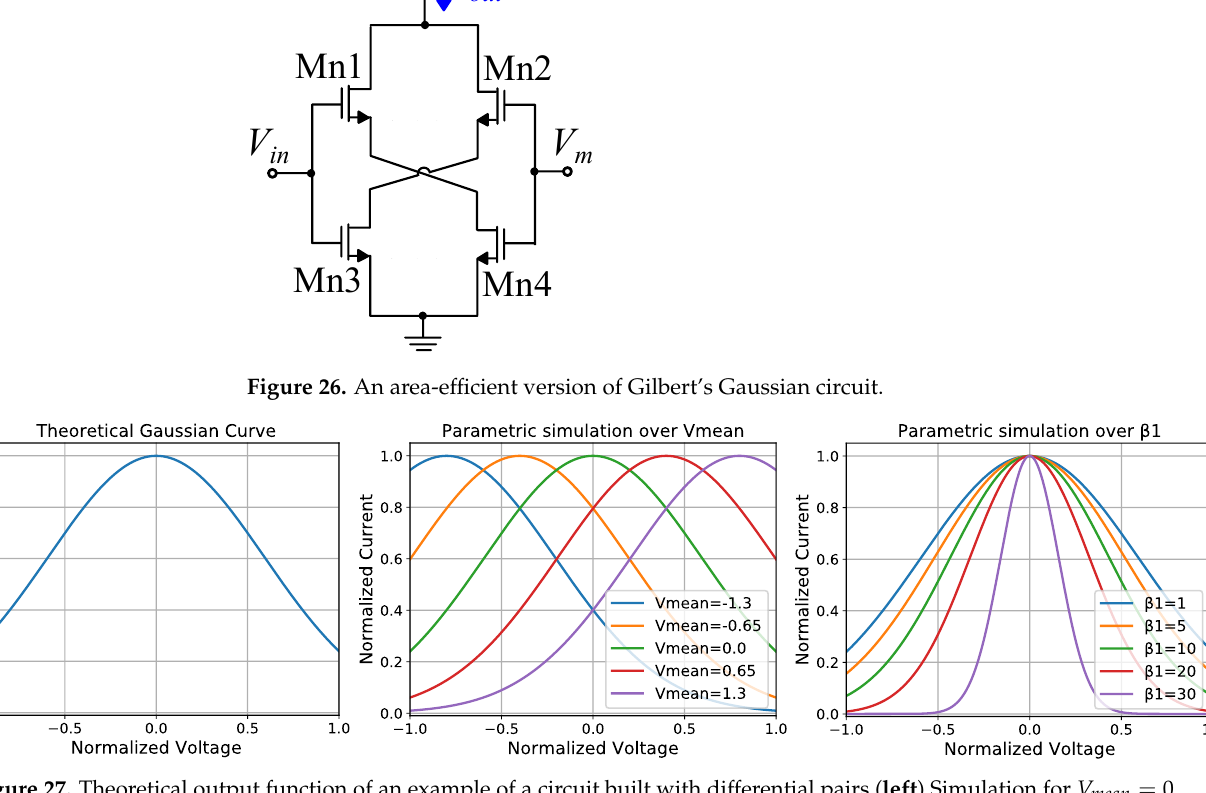
Figure 27. Theoretical output function of an example of a circuit built with differential pairs ( left ) Simulation for V mean = 0 and β 1 = 1 ( center ) Parametric simulation over V mean for β 1 = 1 ( right ) Parametric simulation over β 1 for V mean = 0. Table 4. Gaussian function circuits built with differential pairs. * Additional current sources or resistors. ** Power consumption for the entire